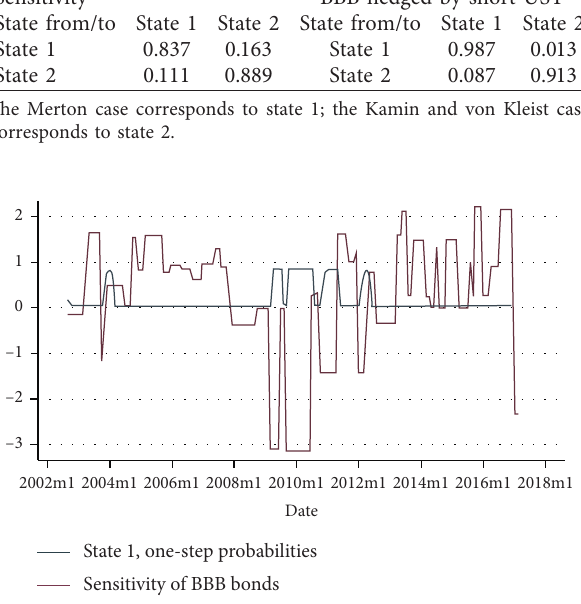
Figure 5: Regime change in means only: state plot for the sen- sitivity time series. Probability with respect to state 1. Table 3: Markov-switching regression in means and standard deviations for